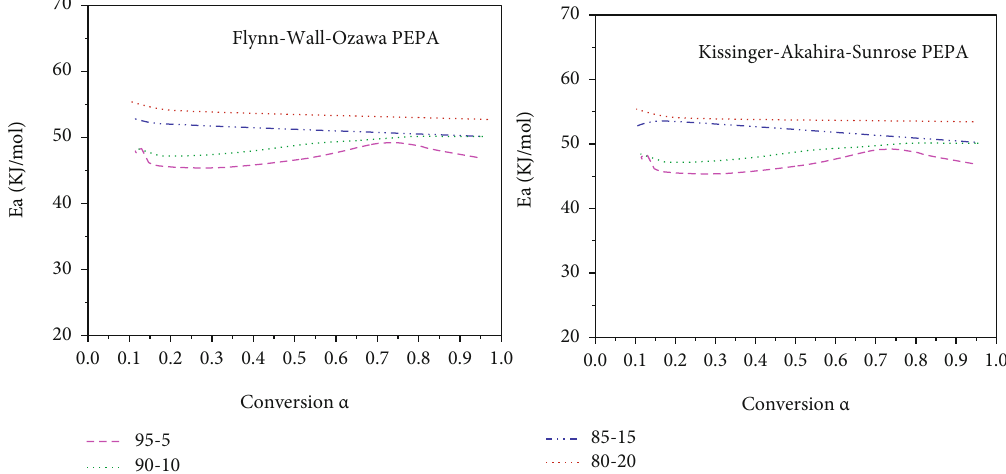
Figure 6: Flynn-Wall-Ozawa and Kissinger-Akahira-Sunose techniques were used to determine the activation energy vs. conversion degree of the PU/epoxy systems